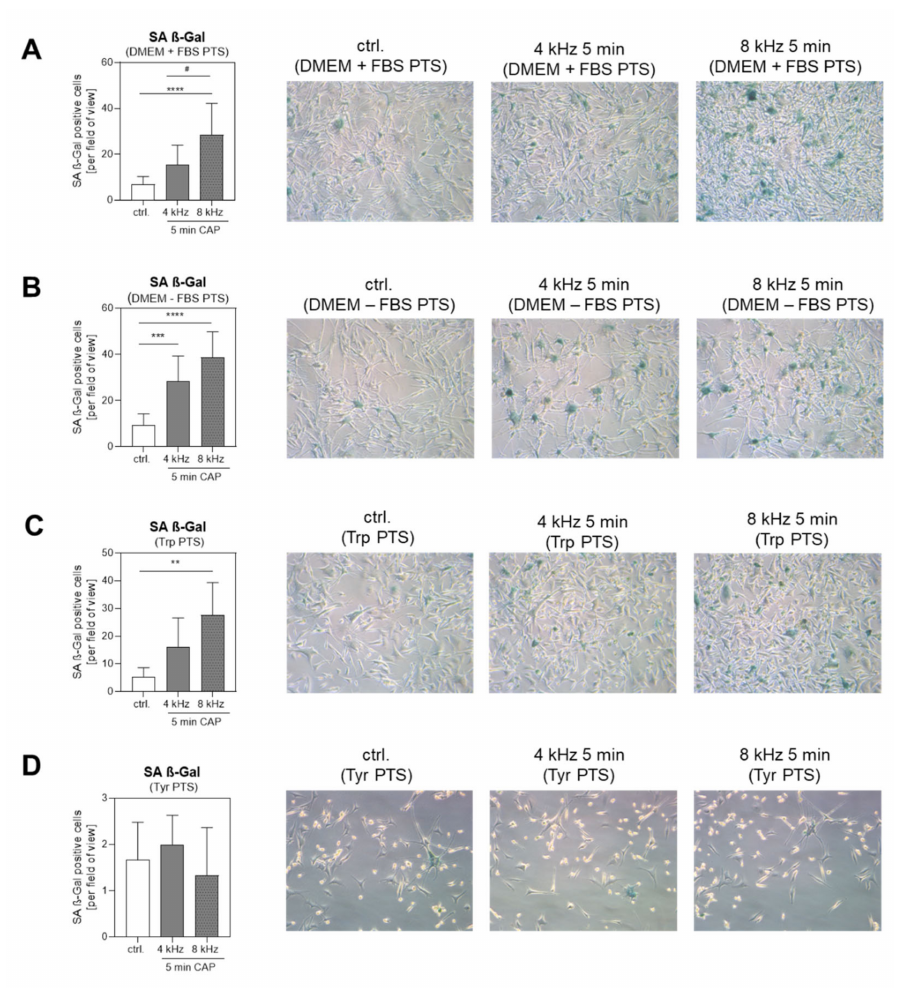
Figure 9. Senescence analysis in Mel Im melanoma cells after treatment with PTS. Light